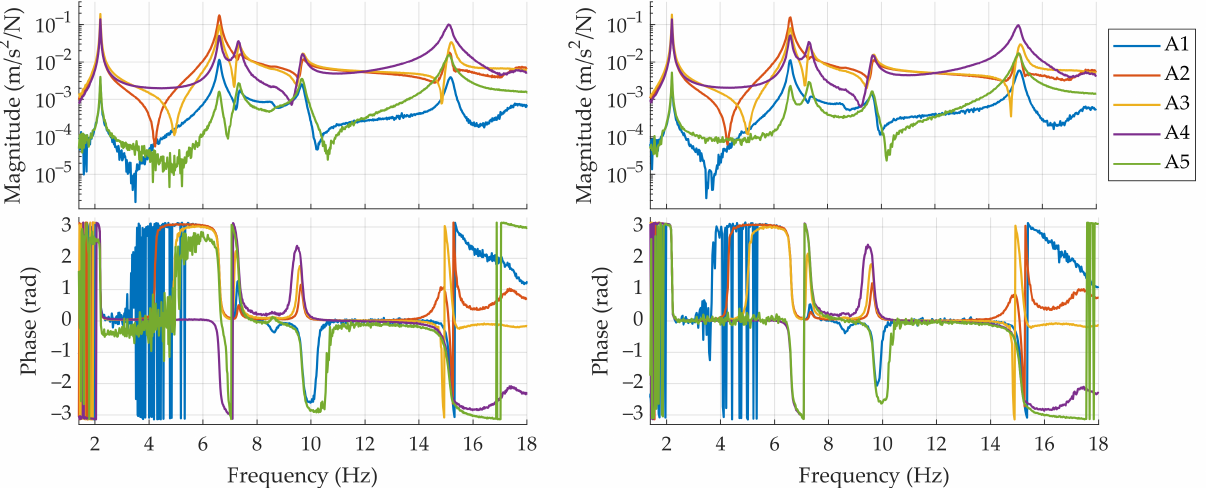
Figure 7. FRFs corresponding to points A1 to A5 estimated by means of the reference system ( left ) and the proposed system ( right